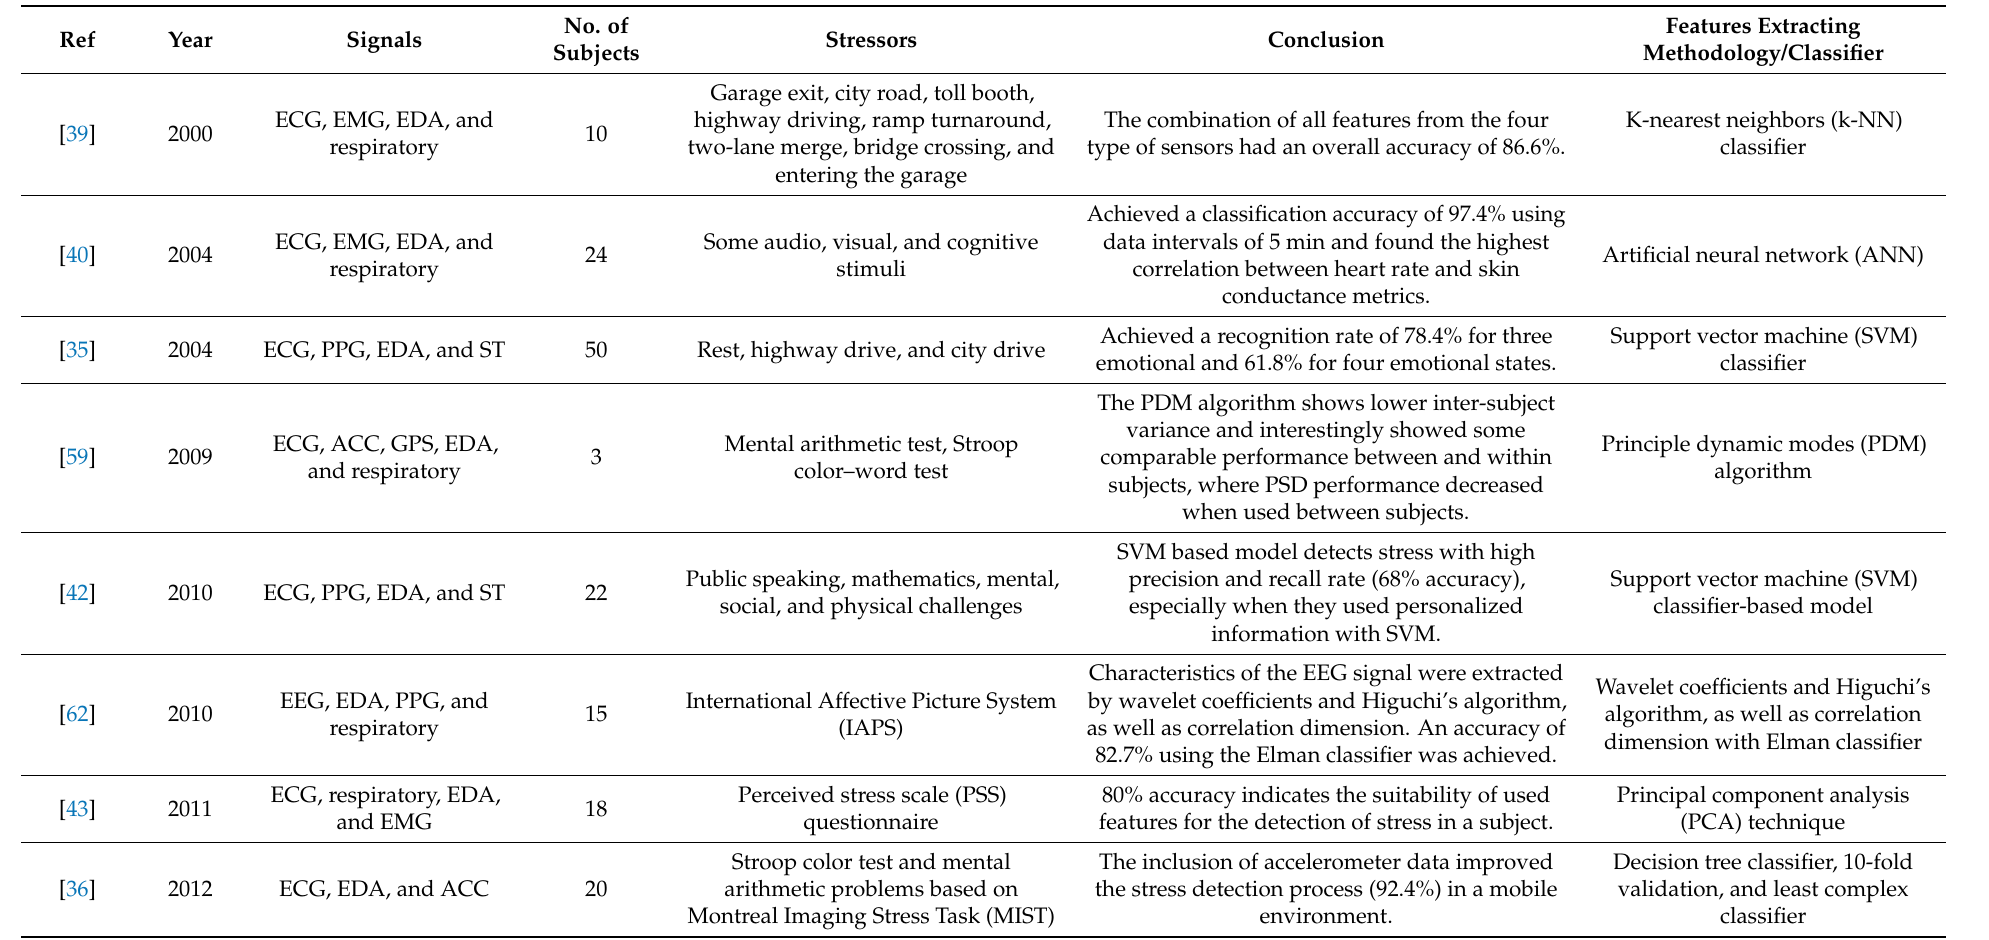
Table 3. Biophysiological parameters (sorted